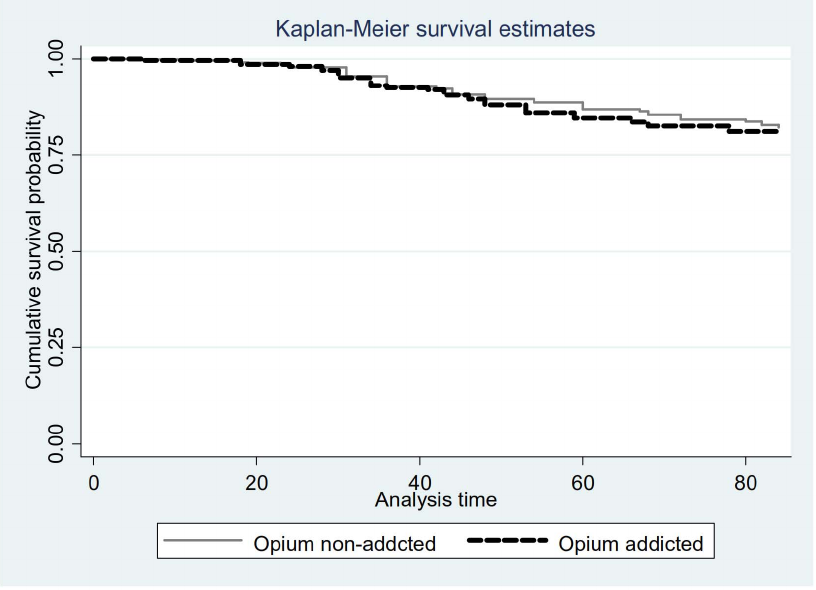
Figure 3. Kaplan-Meier survival estimates of cutaneous leishmaniasis in opium and opium non-addicted.